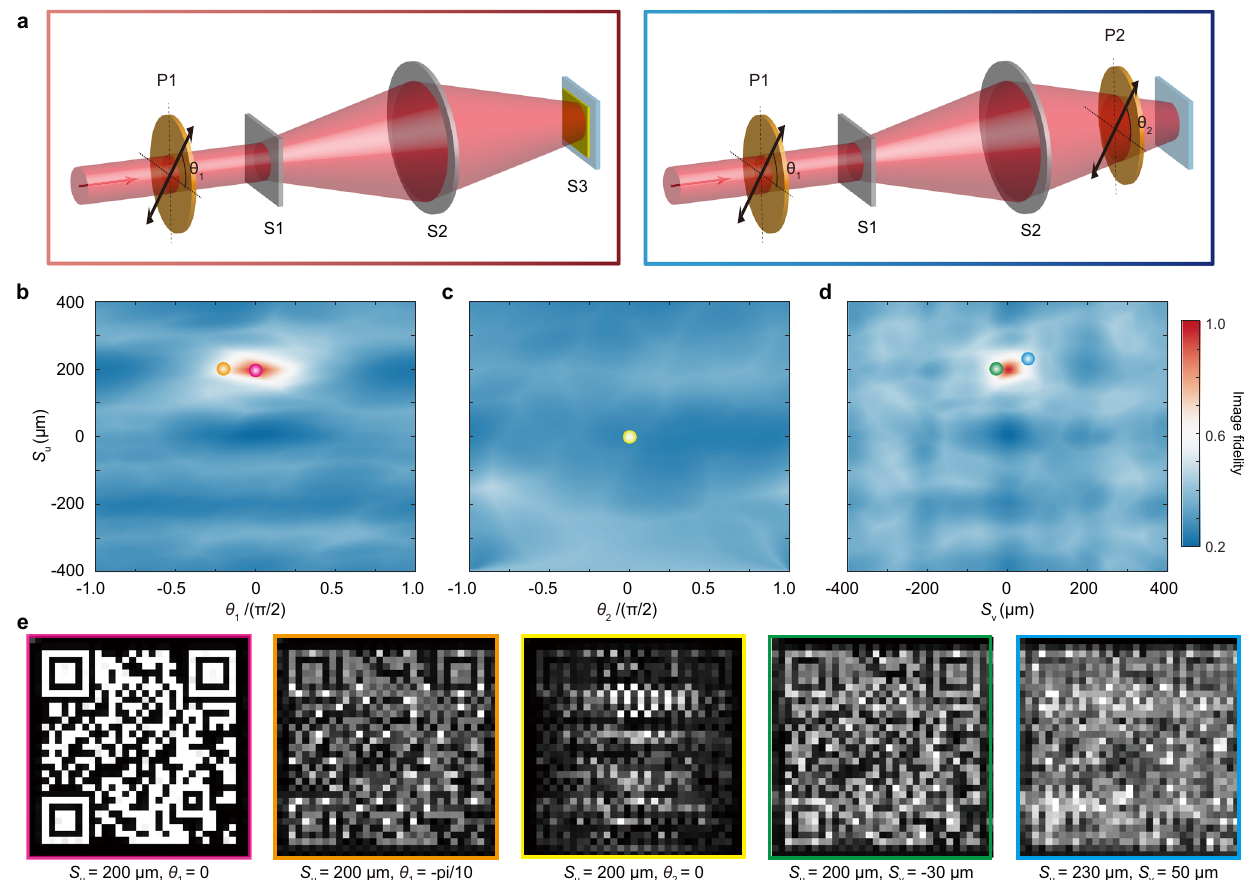
Fig. 4 | Security veri fi cation of the vector VC. a Schematic of optical setups for sensitivity check. Left panel: changing the incident polarization direction by rotating a normal linear polarizer 1 (P1). Right panel: changing the detection polarization direction by rotating a normal linear polarizer 2 (P2) that replaces the vector polarization analyzer (S3). Two-dimensional map of image fi delity as a